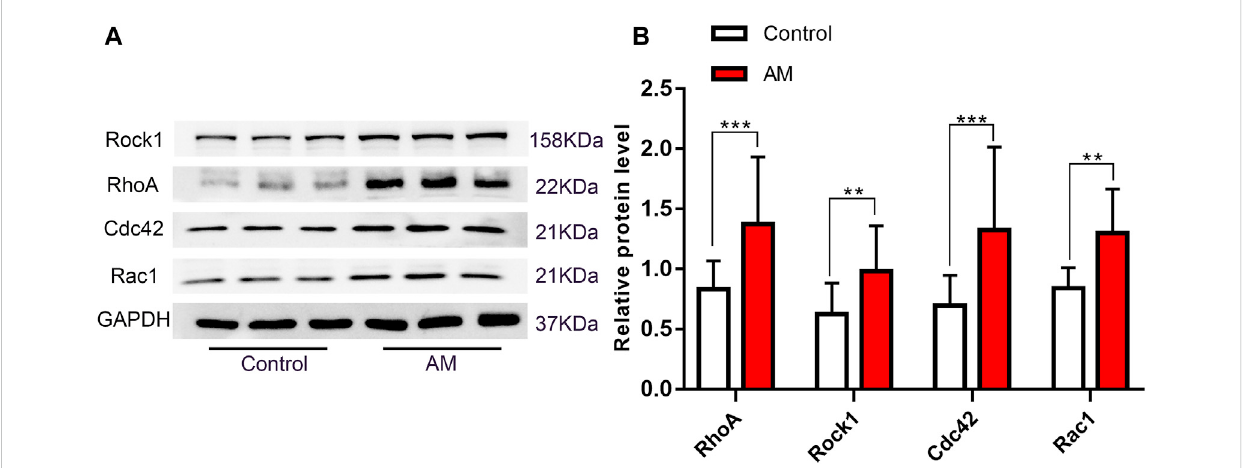
FIGURE 1 ExpressionofRhoGTPasesinuterinetissues. (A) WesternblottingofRhoA,Rock1,Cdc42,Rac1. (B) QuantitativeanalysisofRhoA,Rock1,Cdc42,and